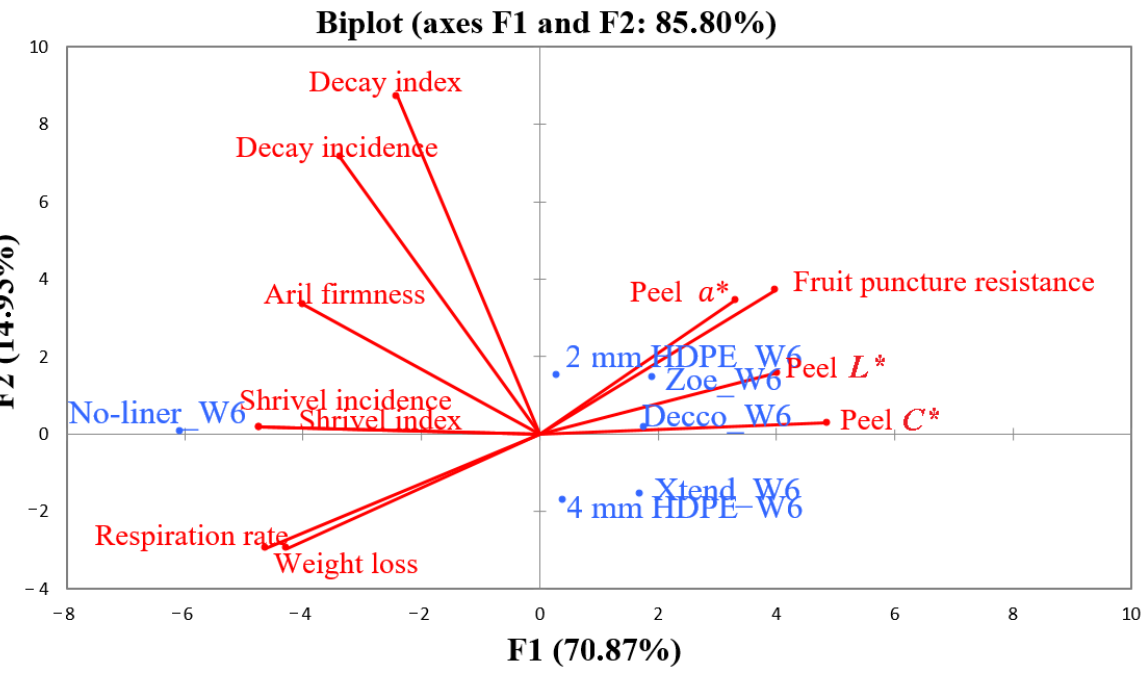
Figure 13. Principal component analysis of the first two factors (F1 and F2) due to physical and physiological attributes of pomegranate (cv. Wonderful) after 42 d of storage at 5 °C and 95% relative humidity (RH). W6 = 42 d. L *: lightness index describes surface color in the range from 0 (black) to 100 (white); a *: redness index describes surface color in the range from green (− a *) to red (+ a *); C *: chroma; HDPE: high density polyethylene.